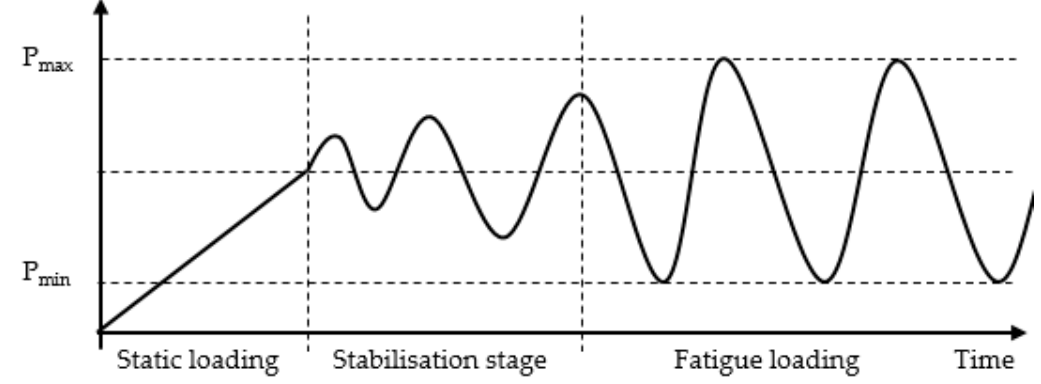
Figure 1. Fatigue load transmission.